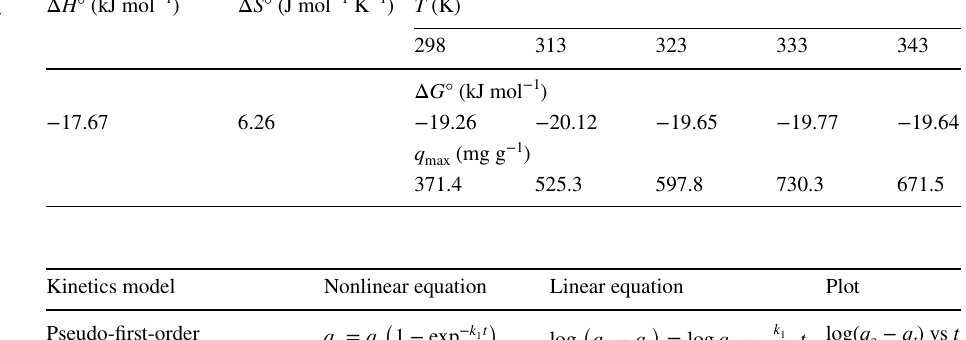
Table 6 Nonlinear and linear equations of pseudo-first-order kinetic and pseudo-second- order kinetic models